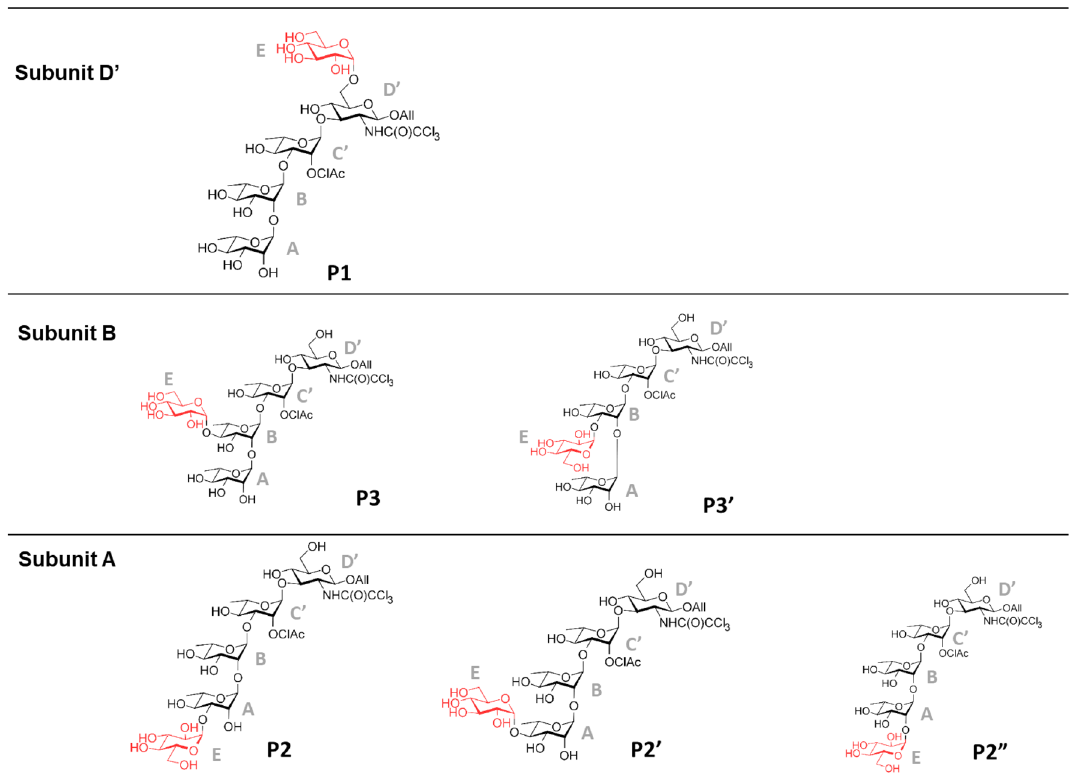
Figure 8. Diversity of pentasaccharides obtained with the BRS-B Δ2 mutants. The various products are shown on the basis of the glucosylated subunit ( A , B or D’ ). P1 ABC’[E(1 → 6)]D’ , characterized in ref 24 .